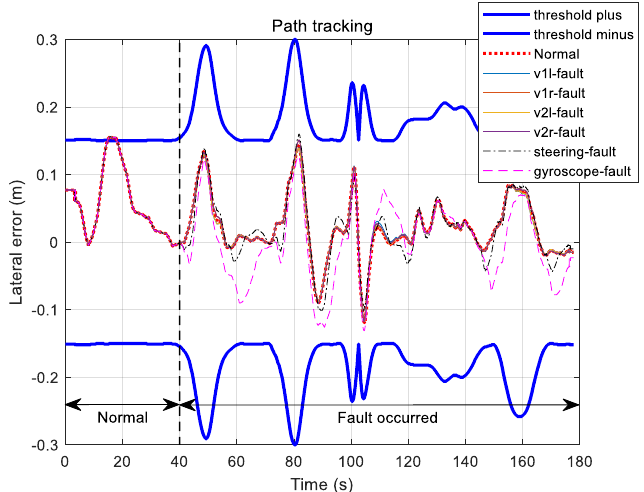
Figure 17. Path tracking errors for each sensor fault recovery.